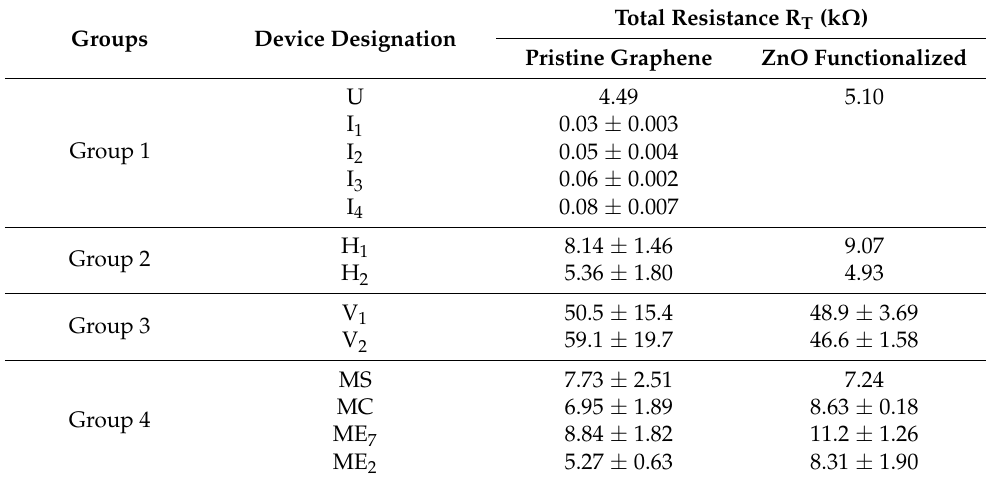
Table 3. The average device total resistance values (R T ) for pristine and ZnO functionalized graphene device structures (open cells indicate devices not